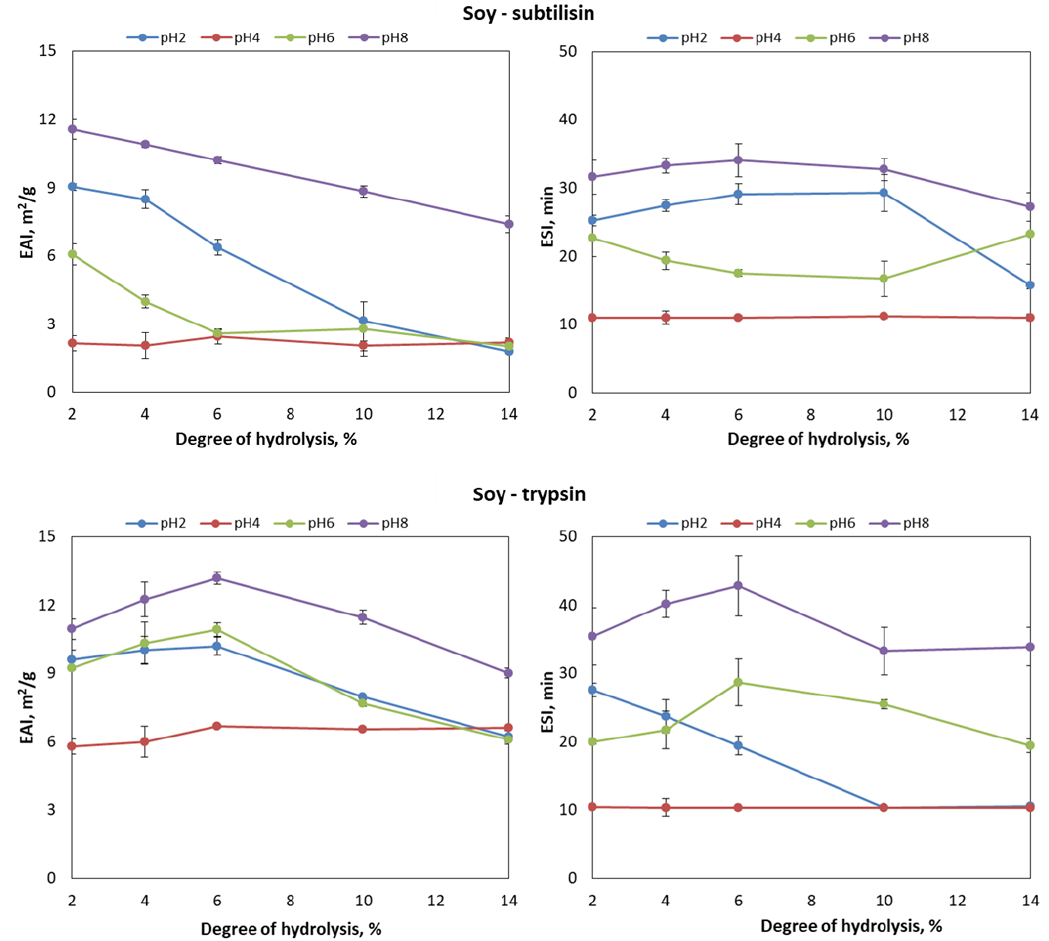
Figure 2. Emulsifying activity index (EAI, m 2 / g) and emulsifying stability index (ESI, min) against pH (2, 4, 6 and 8) and degree of hydrolysis (2%, 4%, 6%, 10% and 14%) for the soy hydrolysates produced with subtilisin and trypsin.